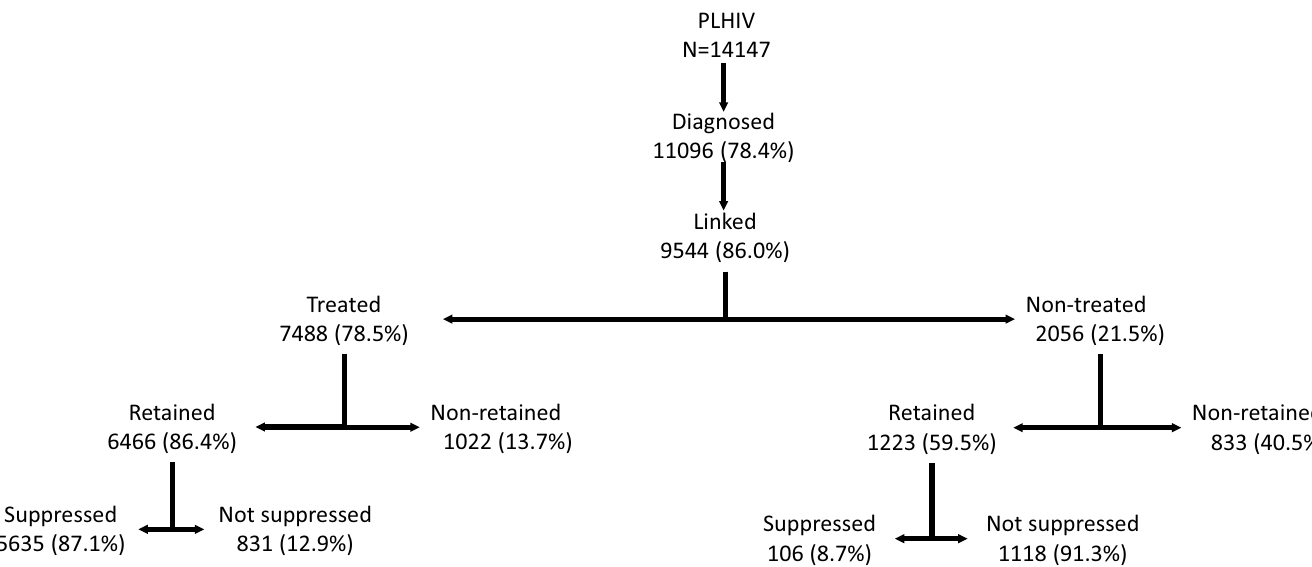
Fig 2. Flowchart of HIV infected individuals’ engagement in each stage of care, by the end of 2013. The estimates of the number of people who are retained to care, currently on treatment and virally suppressed are based on the AMACS cohort data.